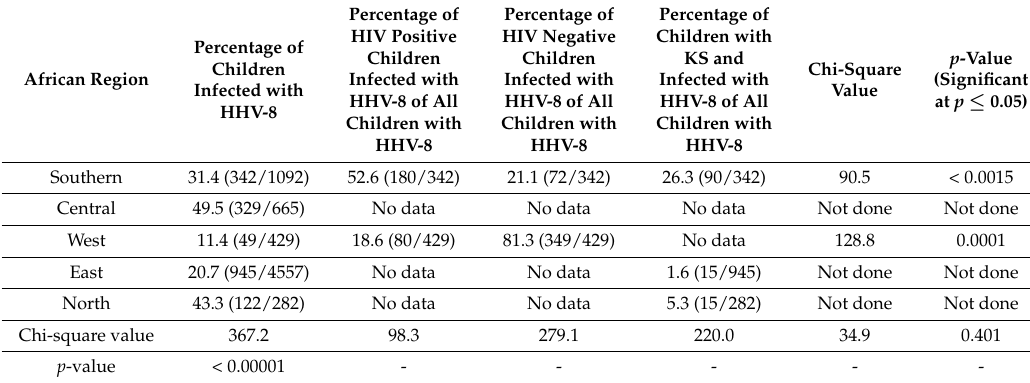
Table 1. Relative HHV-8 infection burden in children, and proportion of HIV positive, HIV negative, and children with KS among the child population in Africa.